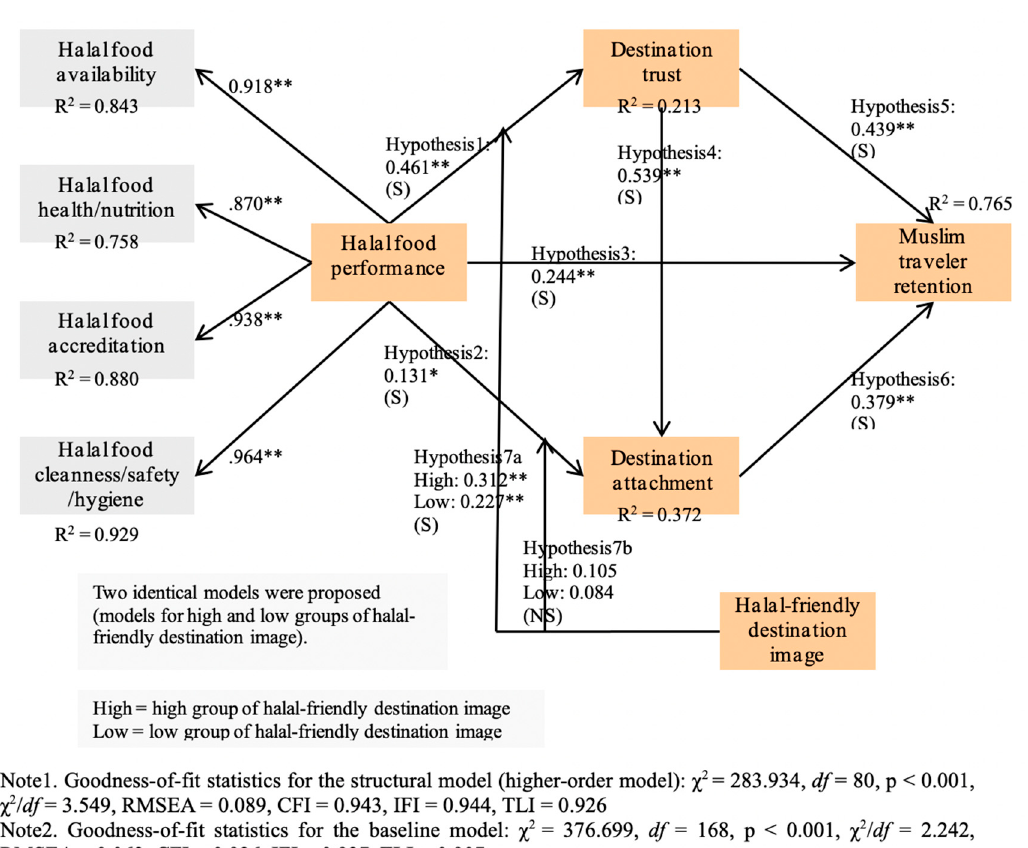
Figure 2. The structural model results.